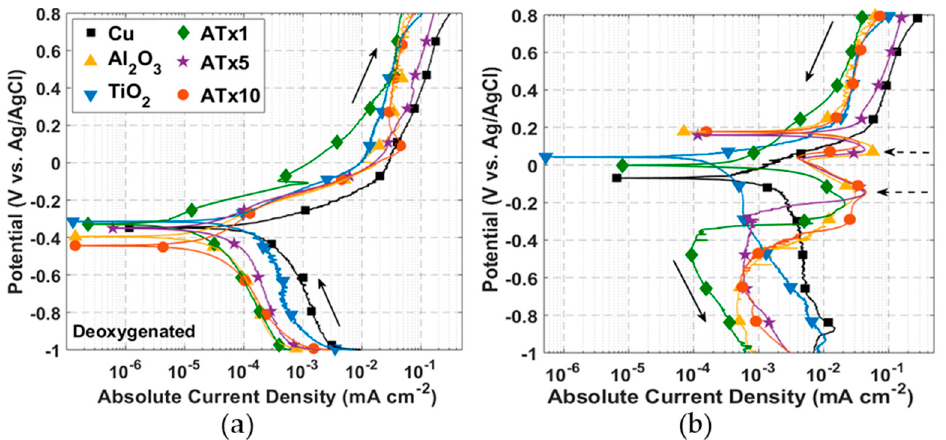
Figure 2. DC polarization curves: ( a ) forward scan [ − 1, 0.8] V and ( b ) reverse scan [0.8, − 1] V measured at a scan rate of 0.5 mV/s in deoxygenated 0.1 M NaCl. Solid arrows specify scan direction and dashed arrows indicate features of interest. Refer to Table 1 for sample descriptions.